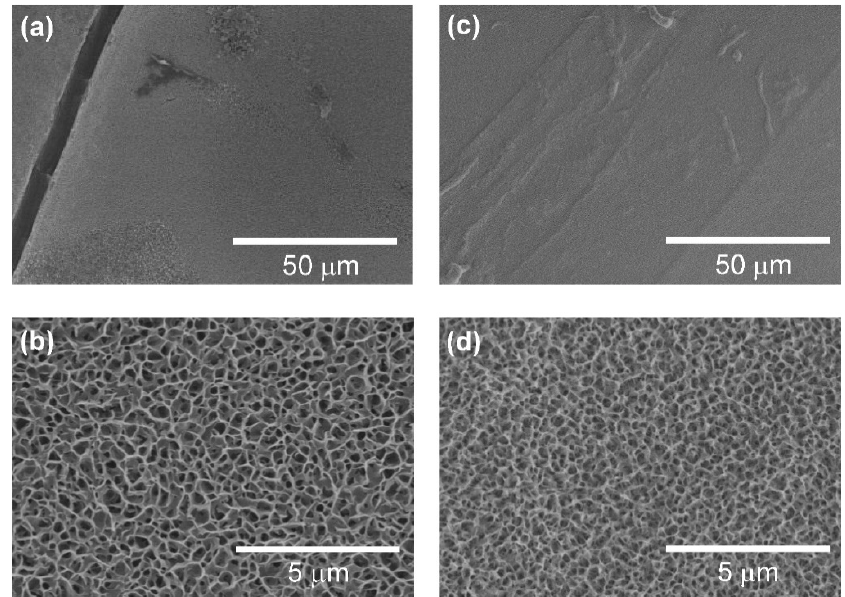
Figure2. SEMimagesofthesurfacesofthe( a , b )fibronectin-immobilizedcalciumphosphate(Fn-CaP)on Figure 2. SEM images of the surfaces of the ( a , b ) fibronectin-immobilized calcium phosphate (Fn- the carbon-preformed optical stamp (Fn-CaP / C / PDMS / PET) and ( c , d ) Fn-CaP on the carbon-preformed CaP) on the carbon-preformed optical stamp (Fn-CaP/C/PDMS/PET) and ( c , d ) Fn-CaP on the carbon- PET (Fn-CaP / C / PET) donor preformed PET (Fn-CaP/C/PET) donor samples.